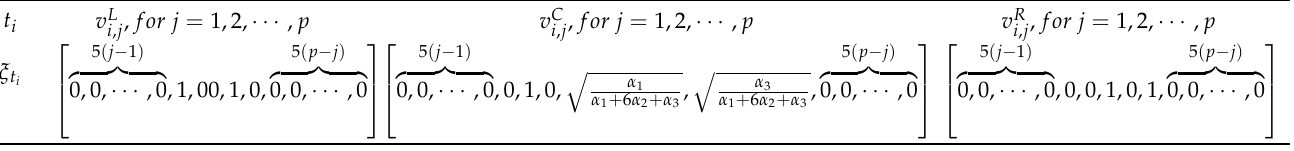
Table 7. ξ for VFCSS applying over TAN-type fuzzy numbers when metric (18.1) is